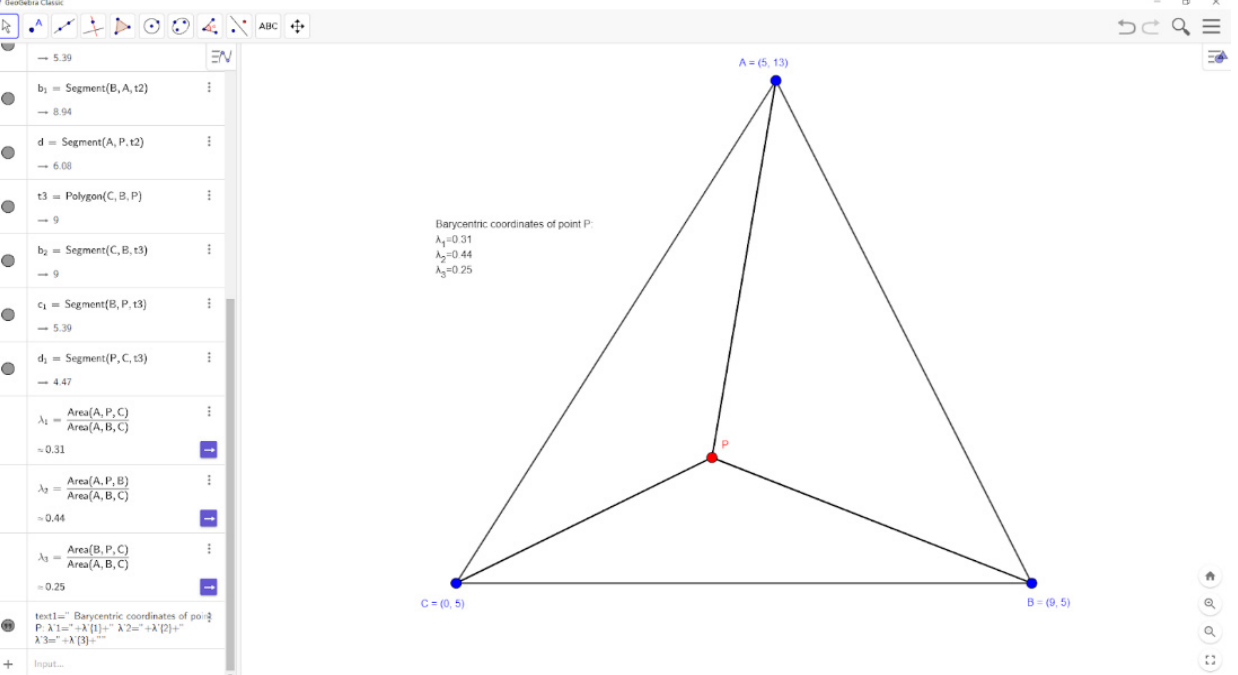
Figure 2. Computing the barycentric coordinates of point P . Rasterization, texture mapping, modeling surfaces, and performing point-in-triangle tests all employ barycentric coordinates in computer graphics.